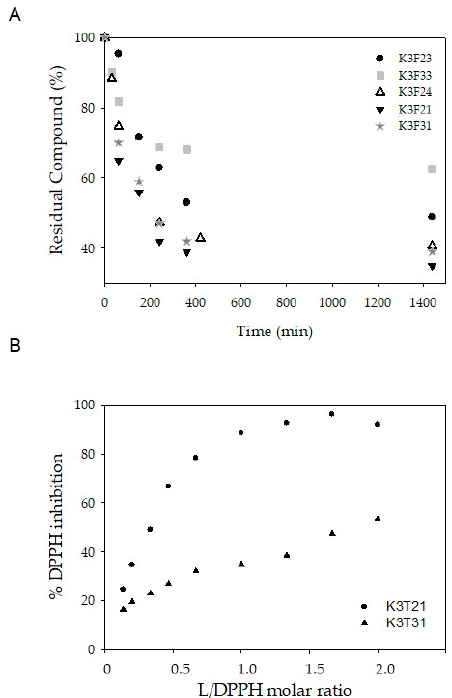
Figure 2. Stability and radical scavenging ability of K3F derivatives. ( A ) Residual % of K3F compounds vs. time (PBS 0.01 M, NaCl 0.1M, pH = 7.4, 37 ◦ C in darkness). Residual % is calculated as A t · 100/A 0 , where A t and A 0 stand for absorbance at λ max at time t and time zero , respectively. ( B ) Percentage of inhibition of free DPPH radical ([DPPH · ] = 60 µ M) in the presence of K3F compounds at increasing concentrations. Compounds concentration is expressed as molar ratio (compound/DPPH).